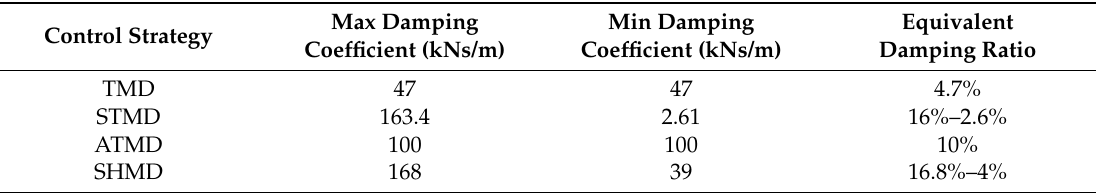
Table 1. Damping coefficients. For clarity i) TMD, ii) STMD, iii) ATMD, iv) SHMD stand for i)